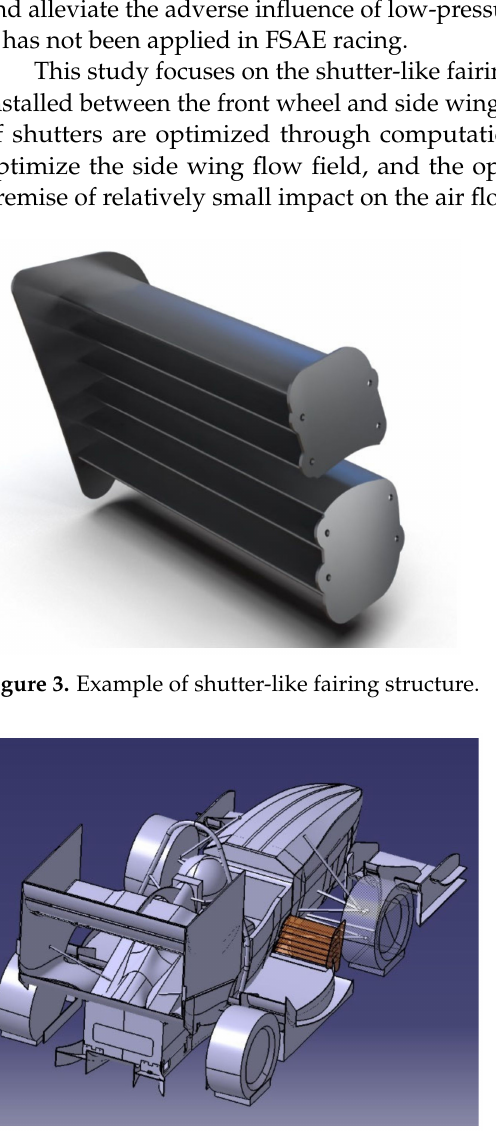
Figure 4. Installation position of shutter-like fairing structure (orange). In our implementation, the shutters are installed between the front wheel and side wing leading edge to combine the low-pressure turbulent airflow above the side